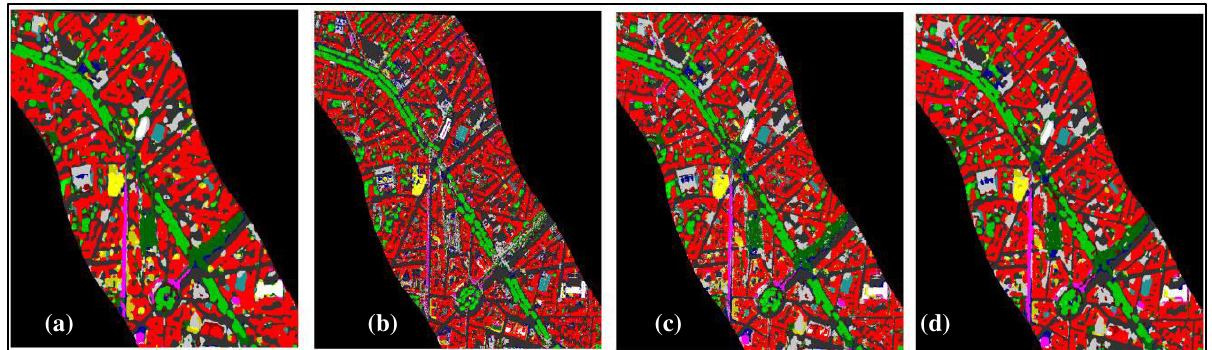
Figure 5. Toulouse Center classification results using the best decision fusion rule; (a) SVM classification of HS image, (b) SVM classification of MS image, (c) Classification fusion by Compromise rule, (d) Global classification regularization.